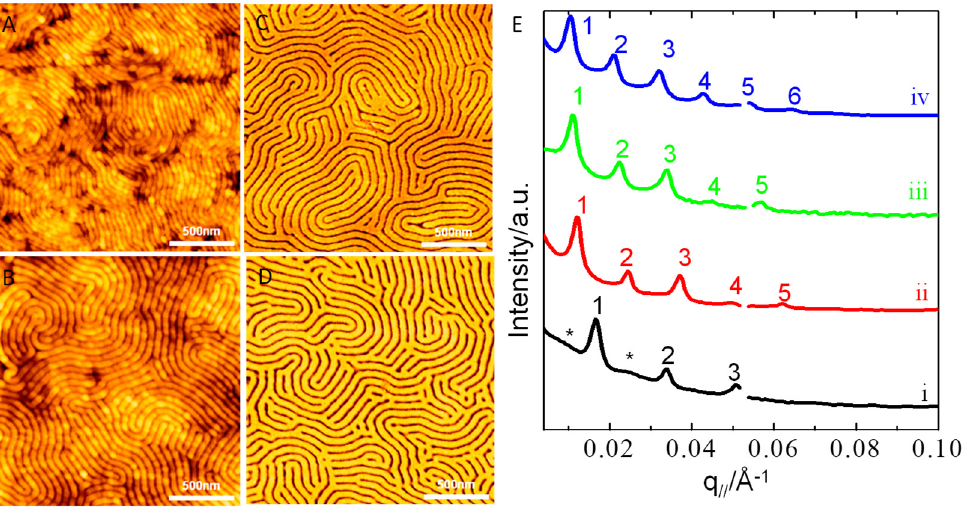
Figure 5. ( A – D ) 2 µm × 2 µm AFM topographies and ( E ) 1D in-plane GISAXS profiles of thin films (h i = 97nm on PS 270n -SiO x /Si) of neat P(S-b-MMA) BCPs of different molecular weights: (A, E i ) P(S 33 -b-M 33 ), (B, E ii ) P(S 45 -b-M 44 ), (C, E iii ) P(S 53 -b-M 54 ) and (D, E iv ) P(S 65 -b-M 61 ). The films were annealed at 230 °C (1 h), and treated by a combination of UV-light exposure (2.5 h) and acetic acid rinsing. In (E), lines i − iv correspond to the 1D GISAXS profiles extracted from in-plane scan cuts along the intense streaks. In curve − E i , broad humps corresponding to the scattering of wrinkles are marked by black asteroids (*). The positions of the diffraction truncation rods are labelled by q // ratios.